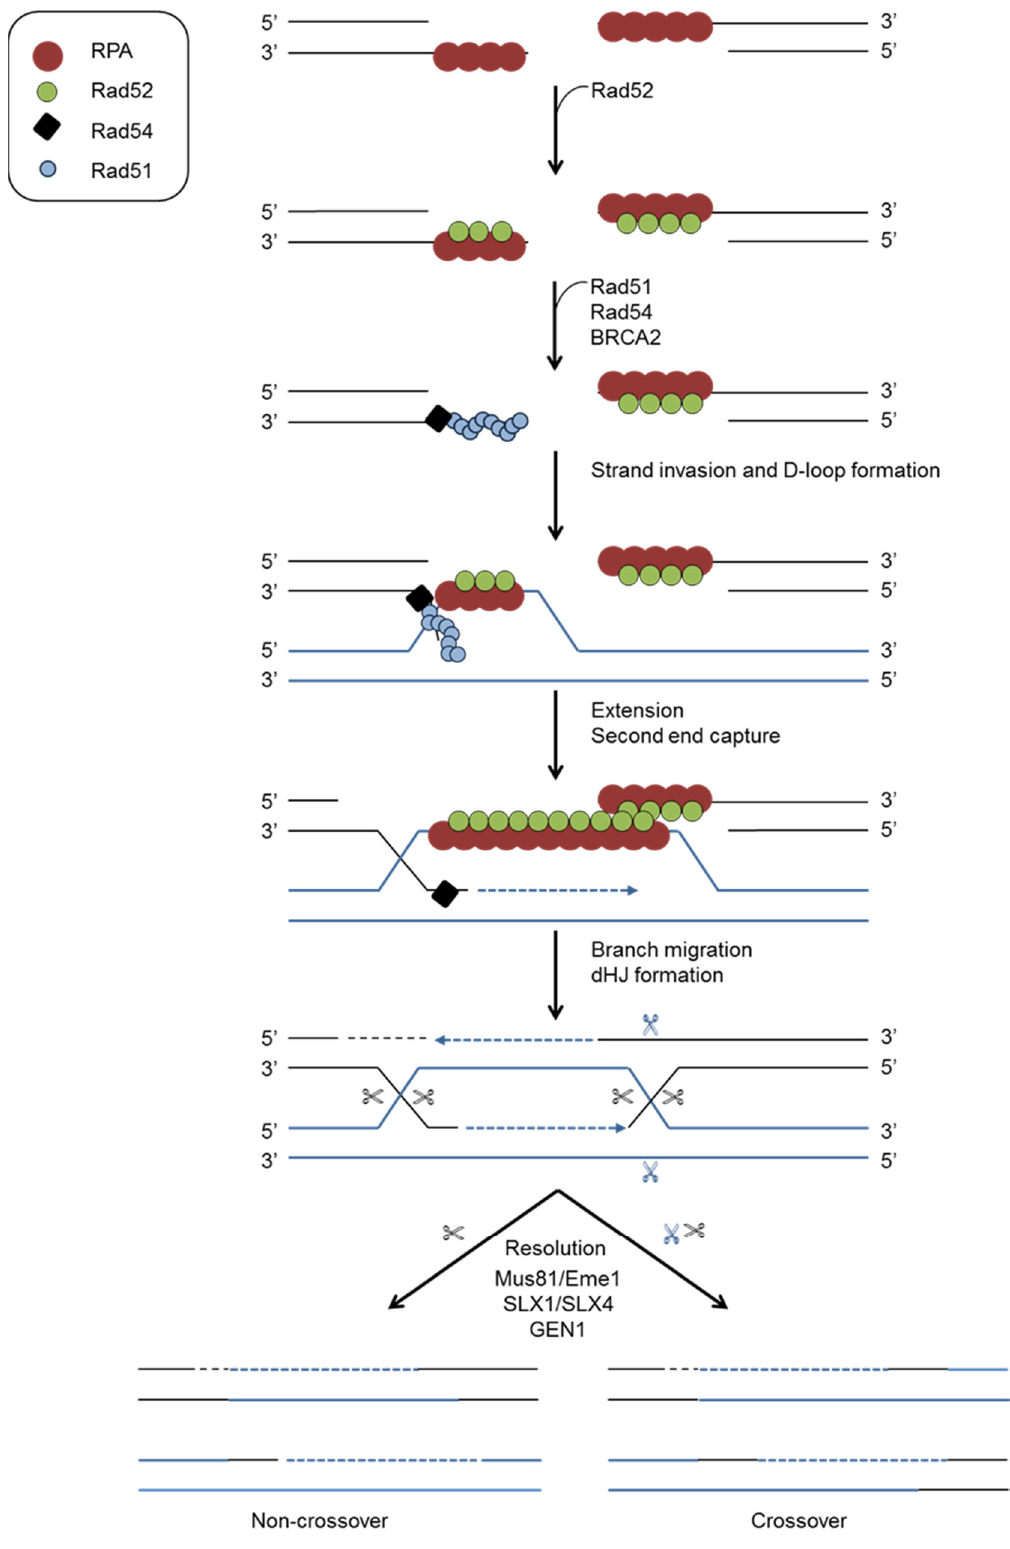
Figure 5. Homologous recombination repair of DBSs. DNA end resection results in ssDNA that is first coated by RPA. Rad51, in conjunction with Rad52 and BRCA2, then displaces RPA. Rad51 and Rad54 catalyse strand invasion and homology search with the undamaged template. Following DNA synthesis via polymerases, the resulting Holliday junctions are